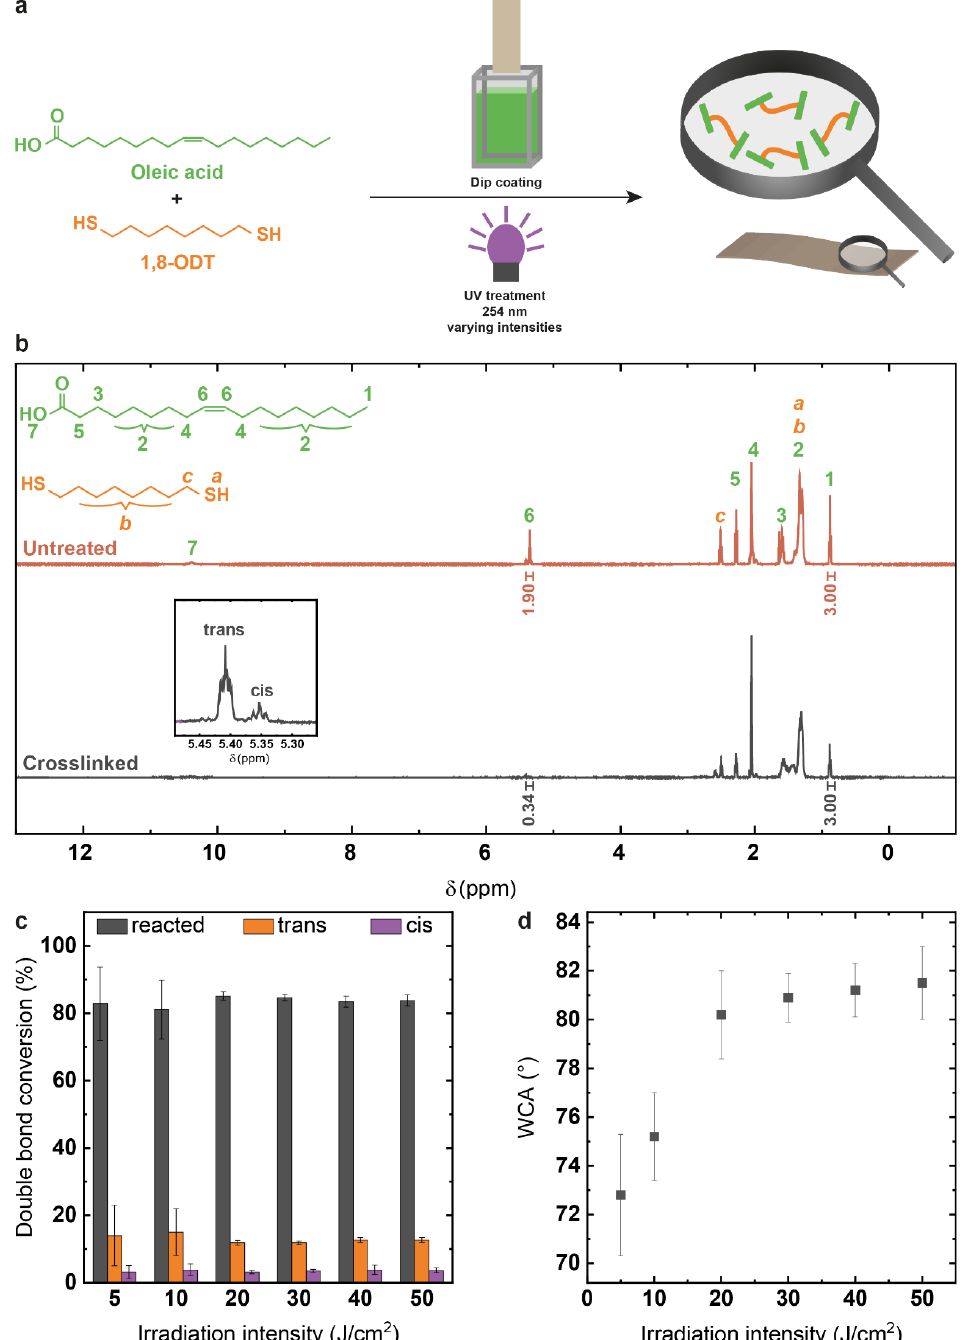
Figure 2. ( a ) Reaction scheme for crosslinking oleic acid with 1,8-octanedithiol and coating application; ( b ) 1 H-NMR spectrum for untreated and crosslinked reactant mixtures as basis for calculating the double bond conversion; ( c ) double bond conversions at different irradiation intensities; ( d ) water contact angles on paper correlating to different irradiation intensities.